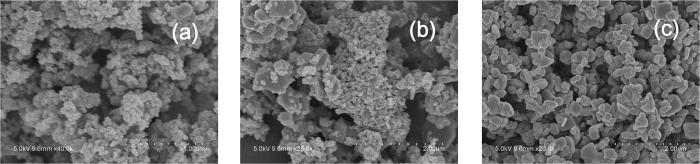
SEM images of MoO2 (a), MMO (b) and MoO3 (c).